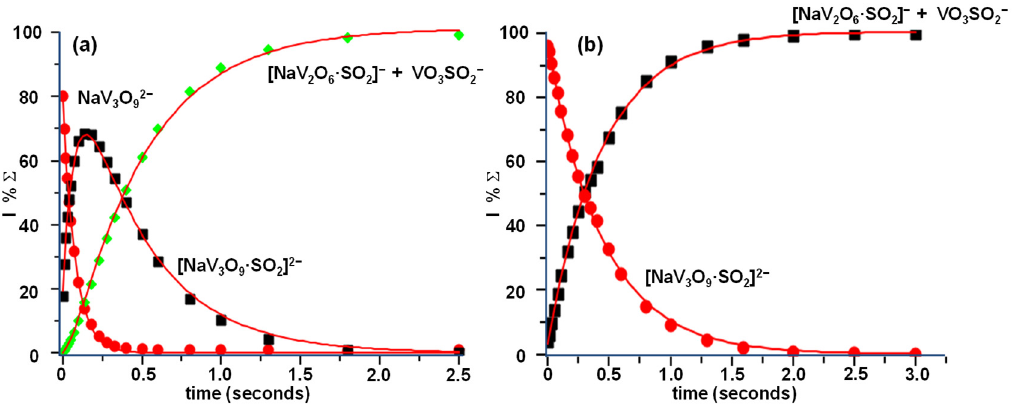
Figure 3. Kinetic plot and best fit lines of the reactions of thermal ( a ) NaV 3 O 92 − ions with SO 2 , P(SO 2 ) = 2.1 × 10 − 7 torr, R 2 (NaV 3 O 92 − ) = 0.9991, R 2 (NaV 3 O 9 · SO 22 − ) = 0.9980, R 2 (NaV 2 O 6 · SO 2 − + VO 3 SO 2 − ) = 0.9992 and ( b ) [NaV 3 O 9 ·SO 2 ] 2 − ions with SO 2 P(SO 2 ) = 2.2 × 10 − 7 torr, R 2 (NaV 3 O 9 ·SO 22 − ) = 0.9997, R 2 (NaV 2 O 6 ·SO 2 − + VO 3 SO 2 − ) = 0.9989.